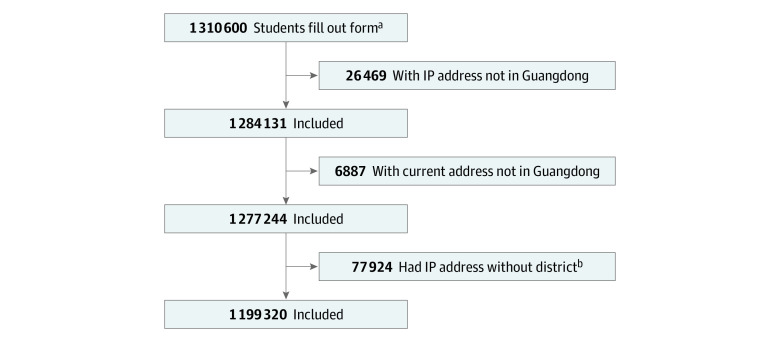
Flowchart of Participant SelectionaOwing to the coronavirus disease 2019 pandemic occurring during the winter vacation, some students went back to their hometown outside of Guangdong province.bSome internet protocol (IP) addresses were in Guangdong province, but the city name was blocked, which would block the analysis of the geographic associations with psychological distress.